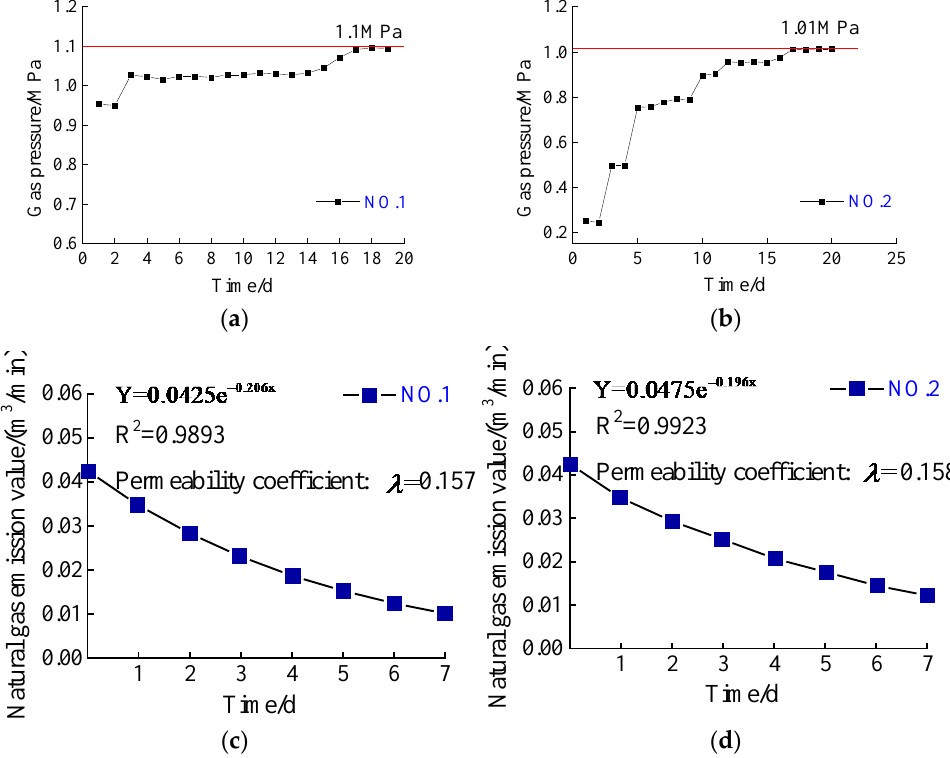
Figure 3. Original area of group Wu coal seam: ( a ) NO. 1 measuring point gas pressure test data; ( b ) NO. 2 measuring gas pressure point test data; ( c ) NO. 1 measuring point permeability coefficient test data; ( d ) NO. 2 measuring point permeability coefficient test data.